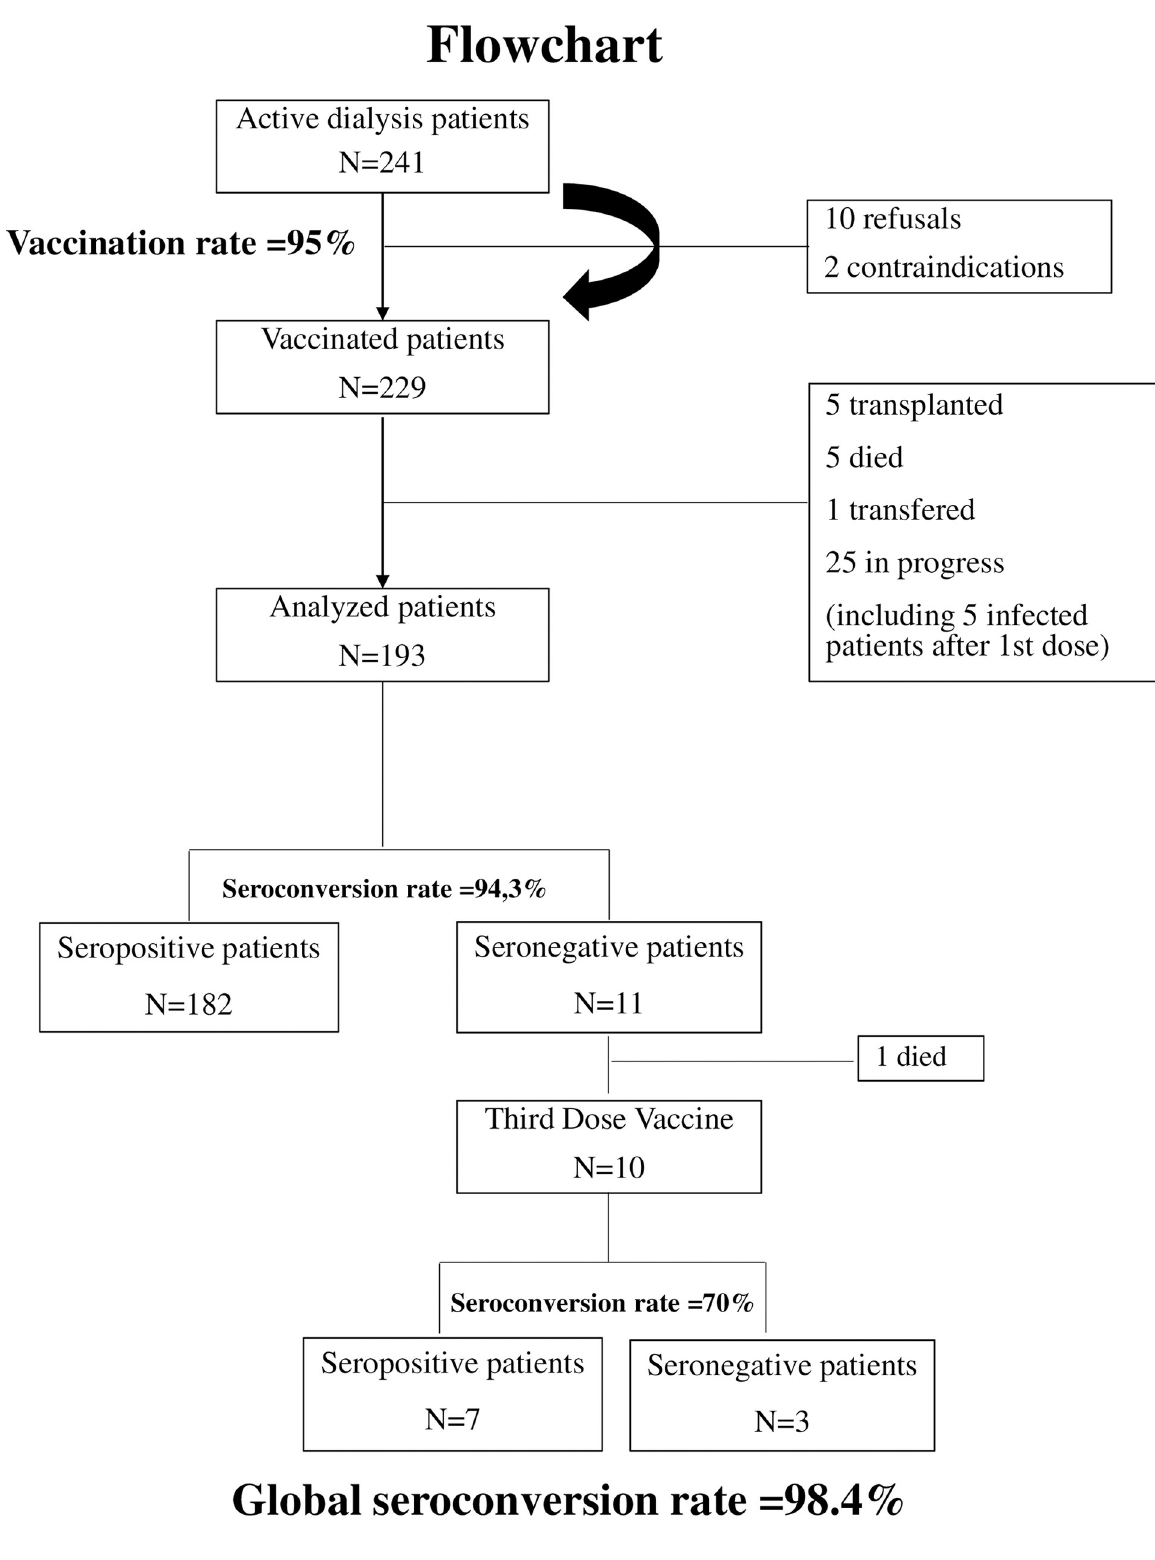
Fig 1. Flowchart of patient receiving BNT162b2-mRNA vaccines and analysed for IgG anti-SARS-CoV-2 Spike-Protein-RBD.